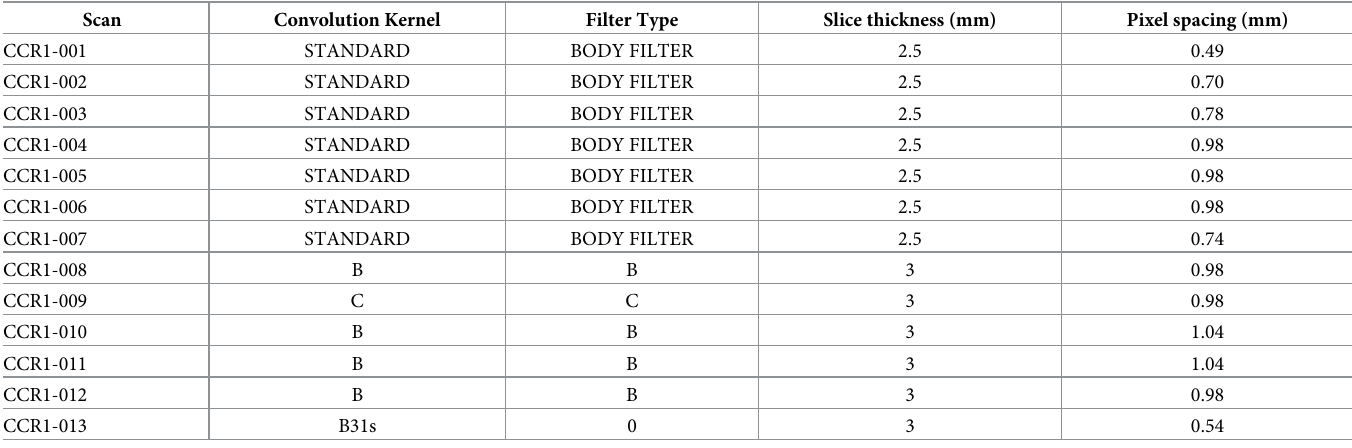
where α is the average value for feature Y for ROI j on scanner i; X is a design matrix of the ij covariates of interest; β is the vector of regression coefficients corresponding to each covariate; γ i is the additive effect of scanner i on features, which is presupposed to follow a normal distri- is the multiplicative scanner effect, which is presupposed to follow an inverse bution; δ i Table 2. CT reconstruction parameters �